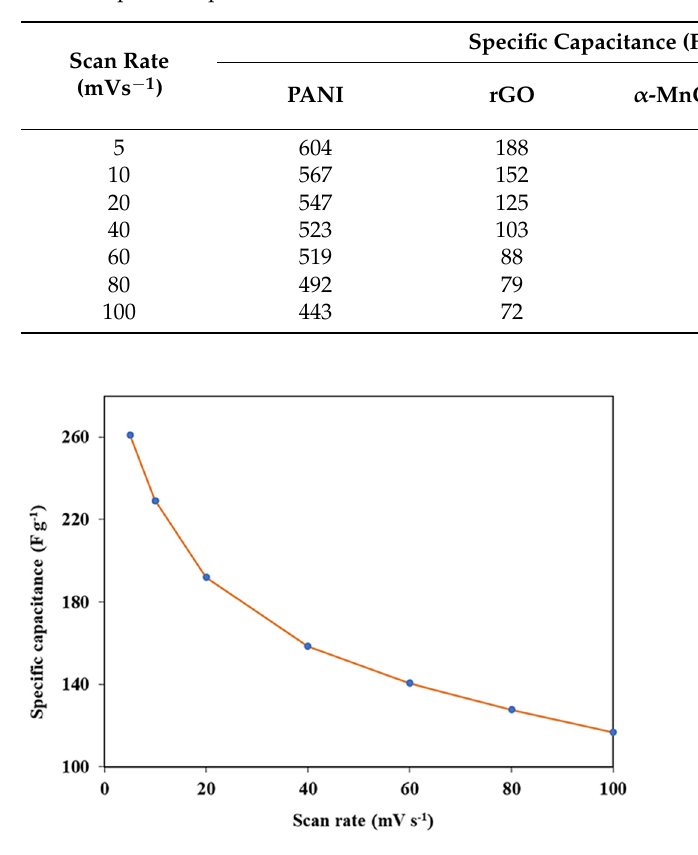
Figure 5. Plot of speci fi c capacitance vs. scan rate of α -MnO 2 /PANI/rGO. Table 1. Speci fi c capacitance values calculated from CV.